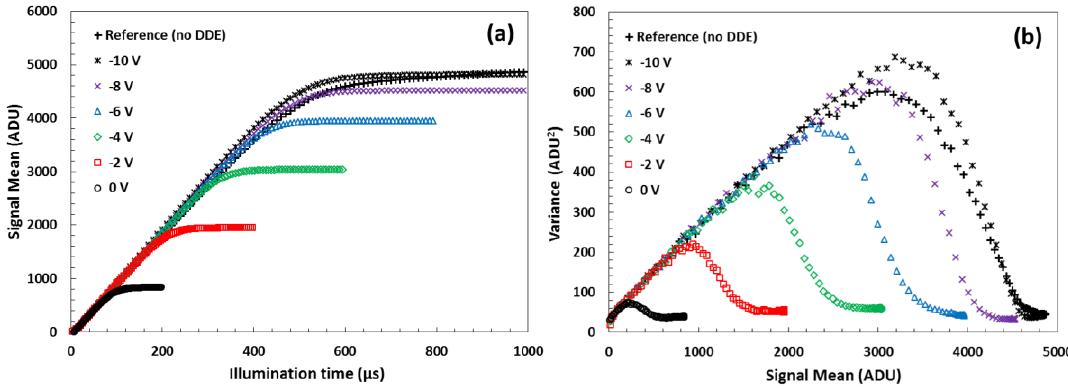
Figure 12. Photo response ( a ) and a PTC ( b ) of a 5.4 µm pixel variant #2 with low V pin and deep DDE for six V BSB values. The threshold voltage V thr for this pixel is 11.8 V.